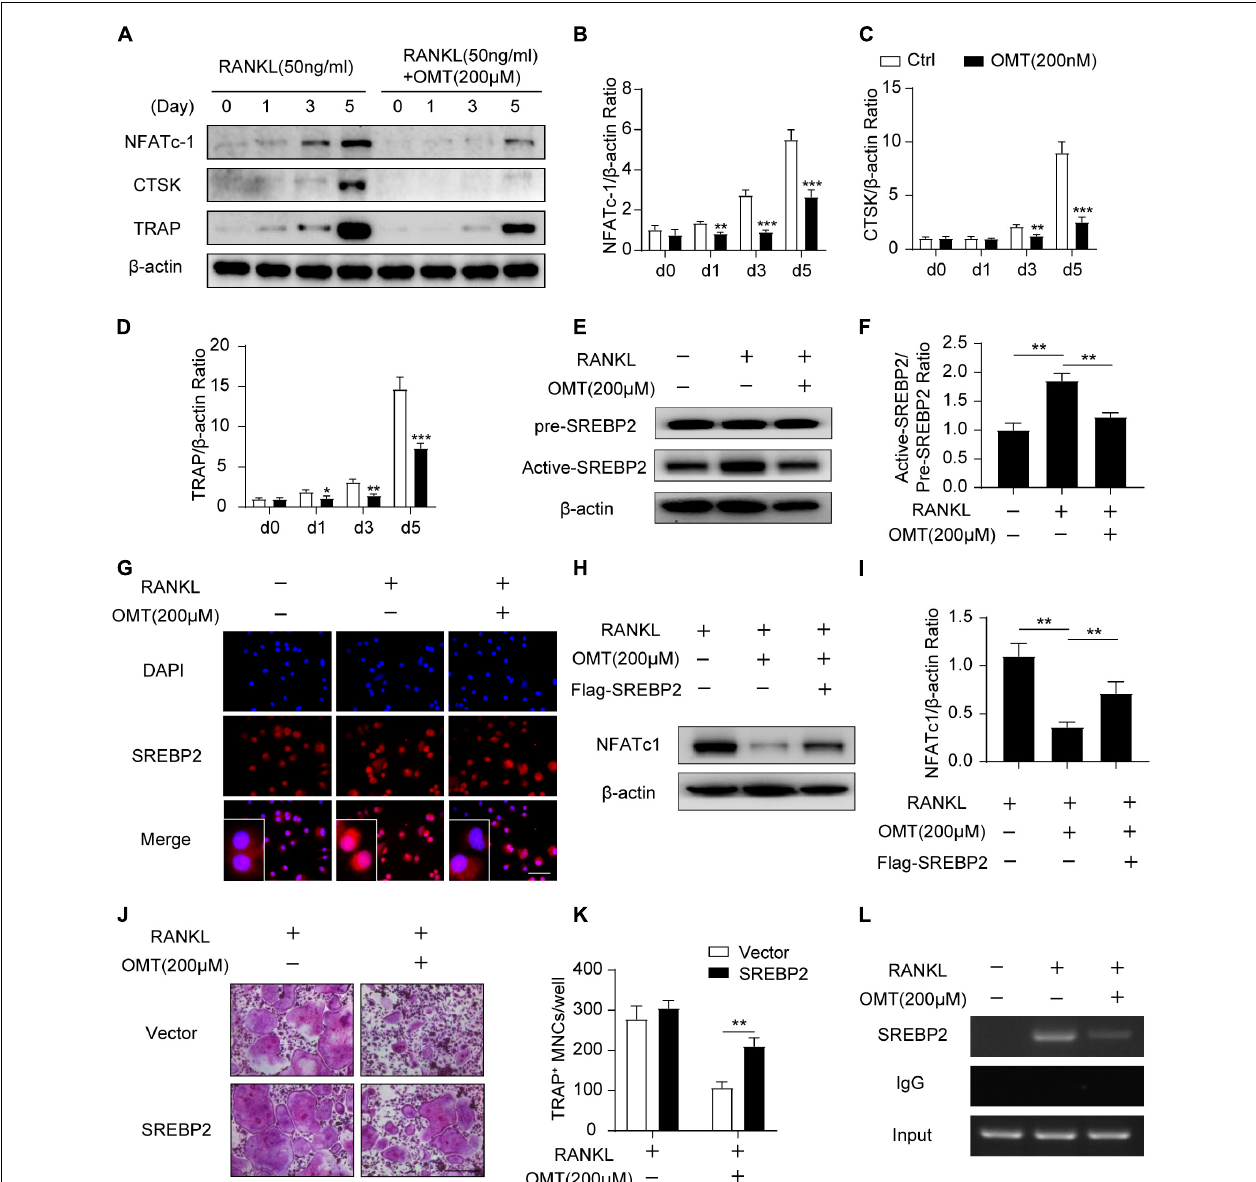
FIGURE 3 | OMT attenuates SREBP2 activity and downstream NFATc1 expression during osteoclastogenesis. (A) BMMs were stimulated with RANKL, with or without 200 µ M OMT for 0, 1, 3, 5 days, the expression of NFATc1, CTSK and TRAP was tested by western blots. (B–D) Quantification of the ratios of band intensity of NFATc1, TRAP, and CTSK relative to β -actin ( n = 3 per group). (E) BMMs were treated with RANKL and 200 µ M OMT as indicated, western blot was used to detect the level of pre-SREBP2 and active-SREBP2. (F) Quantification of active-SREBP2/pre-SREBP2 ratio ( n = 3 per group). (G) RAW264.7 cells were treated with RANKL and OMT as indicated, immunofluorescence assay was performed to detect SREBP2 translocation. Scale bar = 100 µ m. (H) BMMs were transfected with Flag-SREBP2 plasmid or empty vector, then treated with RANKL and OMT as indicated, the expression of NFATc1 was examined. (I) Quantification of NFATc1/ β -actin ratio ( n = 3 per group). (J) BMMs were transfected with Flag-SREBP2 plasmid or empty vector, then treated with RANKL and OMT as indicated. Representative images of TRAP staining were shown. Scale bar = 200 µ m. (K) Quantification of TRAP-positive multinuclear cells per well ( n = 5 per group). (L) ChIP assay was performed on BMMs, treated with RANKL and OMT as indicated. Data were presented as means ± SD. * p < 0.05, ** p < 0.01, *** p < 0.001.